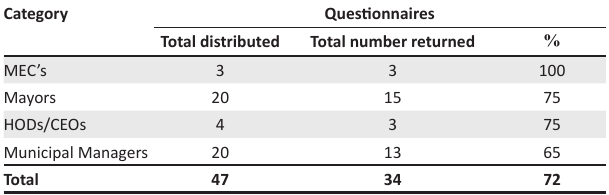
TABLE 1 : Questionnaire